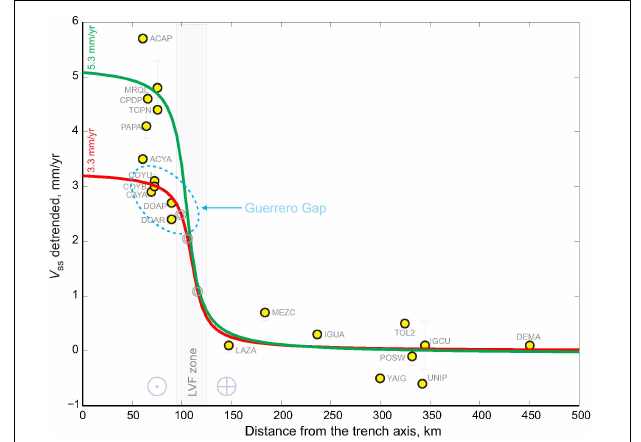
FIGURE 5 | Screw dislocation models in elastic half space for a vertical strike slip fault (Savage and Burford, 1973) in the LVC zone. The models show strike-slip displacement on the surface produced by the creeping fault at the depth more than 10 km. The fault is locked from 0 to 10 km. Yellow circles are detrended trench parallel rates ( V ss, wrt NA fixed plate) at the permanent GPS stations (see Figure 1 ), (cid:49) V ss, (after the secular linear strain trend is subtracted from the V ss). The trend north from the LVF fault zone is produced by the simple shear in the upper 10 km of the locked fault segment. Red line is a feasible fit for the V ss in the area of the Guerrero seismic gap (G-GAP, ∼ 100–101 ◦ W) for the Xolapa sliver velocity, (cid:49) V ss, of 3.3 mm/year. Green line is the fit for V ss values for the Guerrero GPS stations located off the G-GAP, and (cid:49) Vss = 5.3 mm/year. Light gray band indicates the LVF zone. Error bars are 3 σ . Gray open circles show only locations of three GPS stations recently installed in the LVF zone to constrain better the fault model.